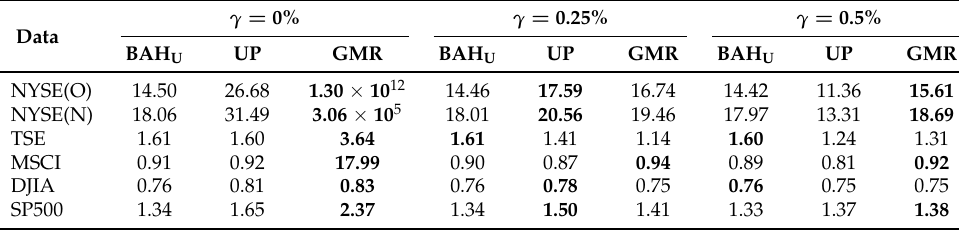
Table A2. Cumulative wealth on traditional datasets. The best values are shown in